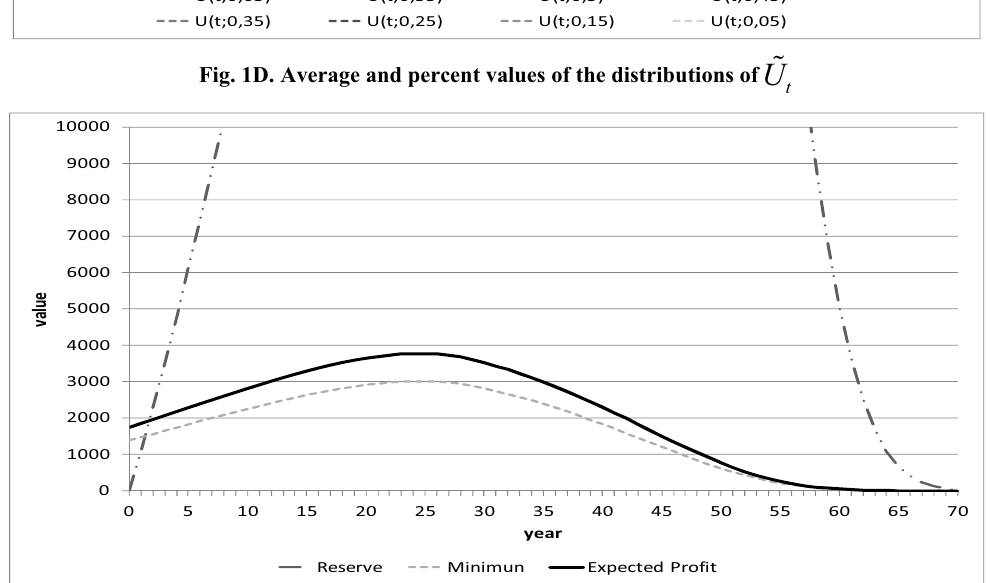
Fig. 2D. Average values of the distributions of